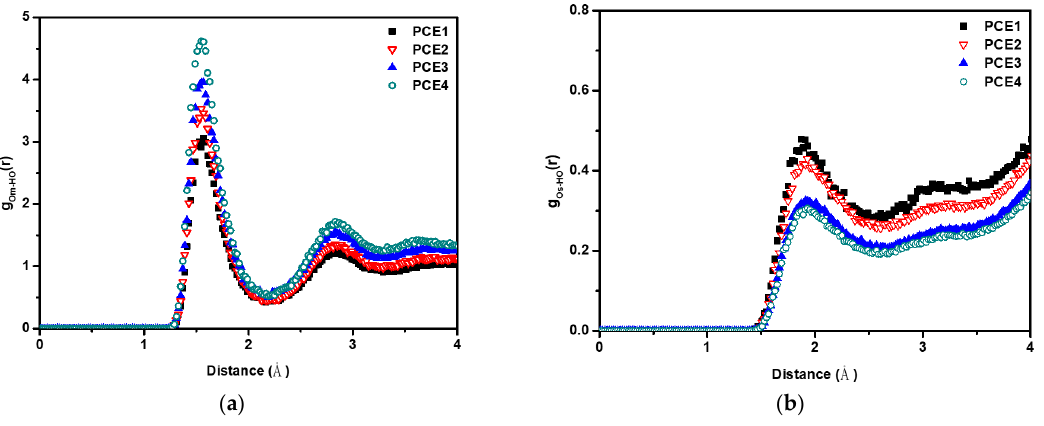
Figure 7. The RDFs ( a ) g Om-HO (r) and ( b ) g Os-HO (r) in PCE aqueous systems.